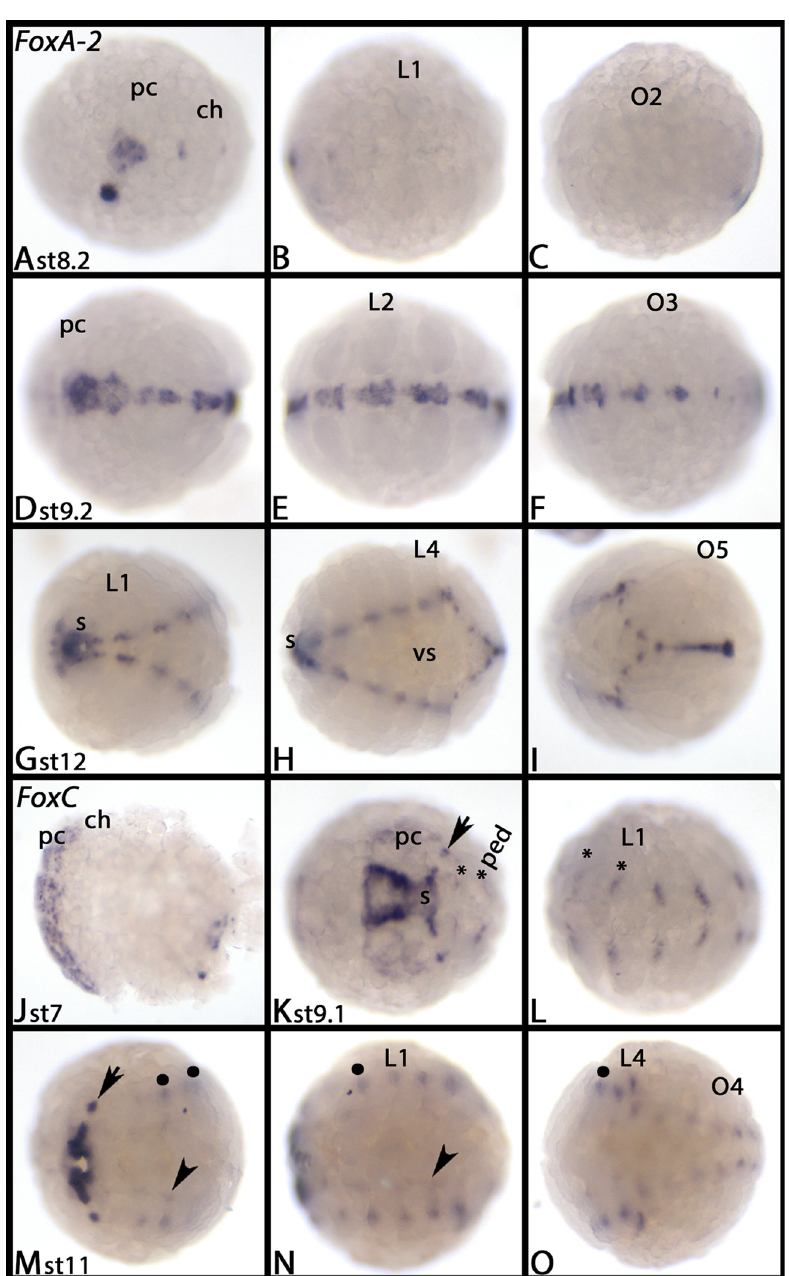
Fig 2. Expression of Parasteatoda FoxA-2 (A-I) and FoxC (J-O). In all panels, anterior is to the left, ventral view. Panels A, D, G, K, and M view of anterior with head. Panels B, E, H, L, and N view of middle part with walking limbs. Panels C, F, I, O view of opisthosoma. Arrows in panels K and M point to lateral expression in the head. The arrowheads in panels M and N point to faint expression at the ventral rim of the split germ band. Asterisks in panels K and L mark expression in the VNS. Filled circles in panels M-O mark expression at the base of the walking limbs. Abbreviations in Table 2. DAPI staining of the embryos shown in this figure are presented in S6 Fig. After germ band retraction, FoxC is also expressed in the developing heart (cf. expression of FoxF , below) (S9F Fig, short arrow). Expression of FoxC in the head has also been reported previously by [46] Economou and Telford (2009).